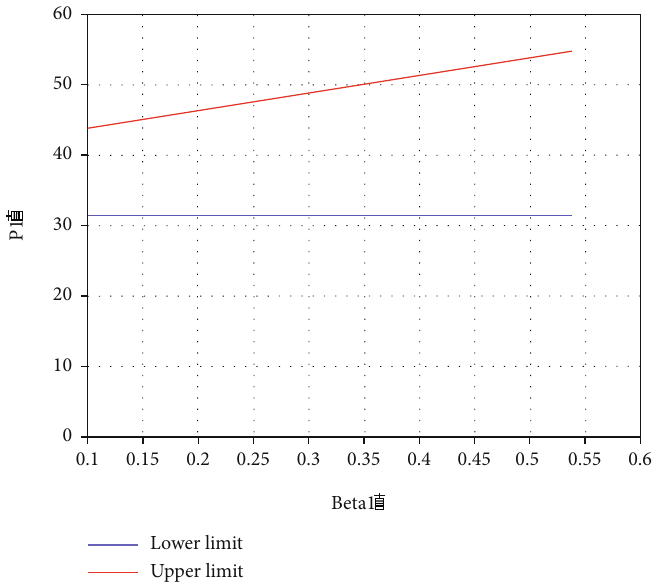
Figure 5: Comparison of psychological pricing and platform